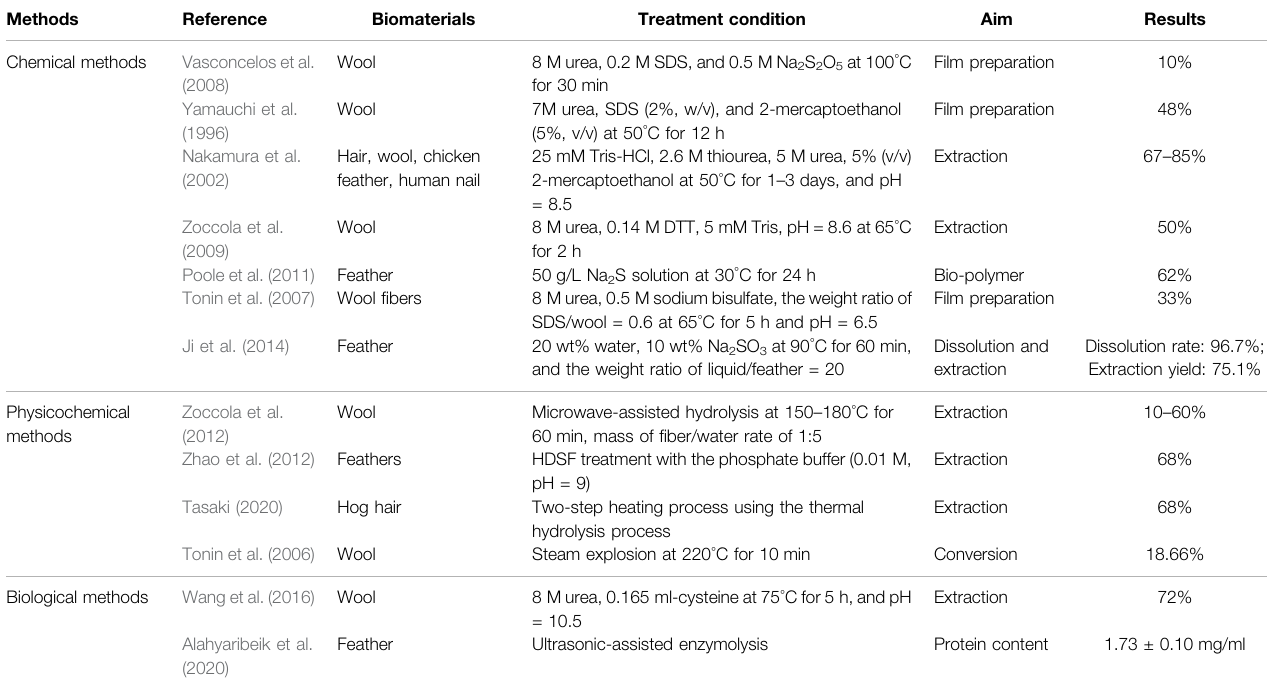
TABLE 1 | Methods to extract and dissolve keratins from different biomaterials.